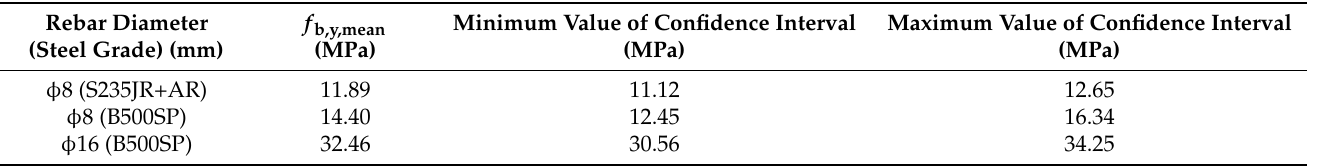
Table 5. The adhesive stress values f b,y corresponding to the mean force F y yielding the reinforcement and the confidence intervals at the significance level of 0.02 corresponding to these stresses. Rebar Diameter